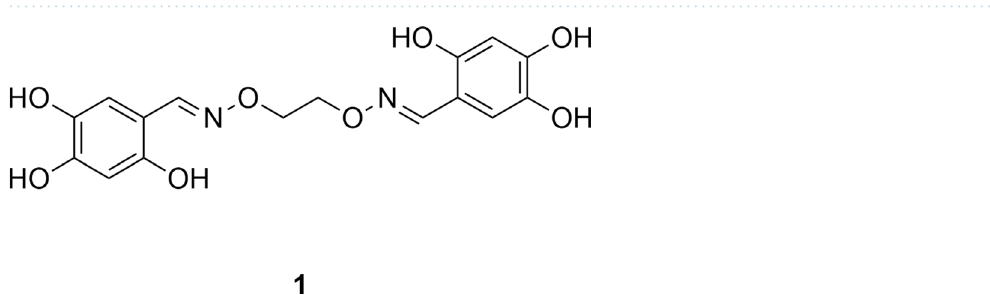
Figure 6. Example structure of the literature known DXS inhibitor class of hydroxybenzaldoximes 1 36